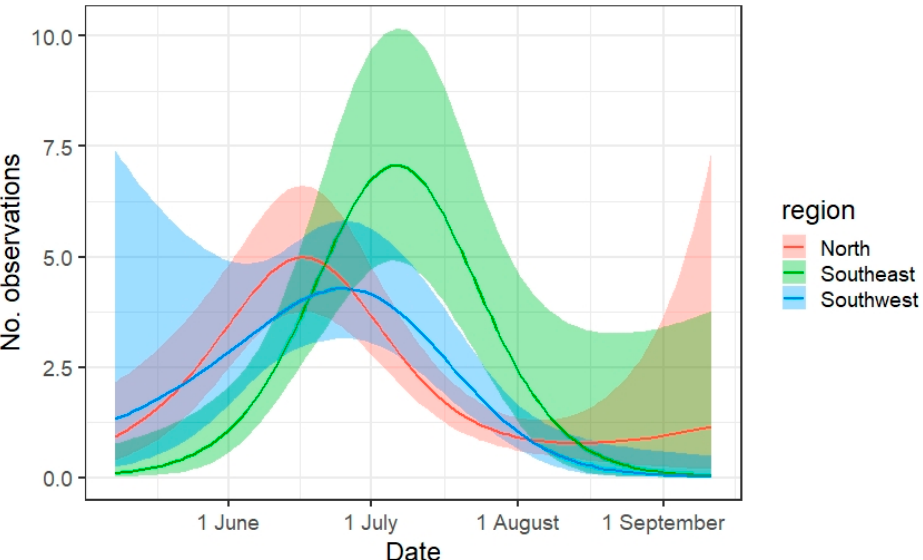
Figure 3. Modelled phenology of the number of observations along a transect walk given for three regions. Model outcome is plotted as a line with the confidential interval as a ribbon, after taking into account the effect of the other variables in the model.